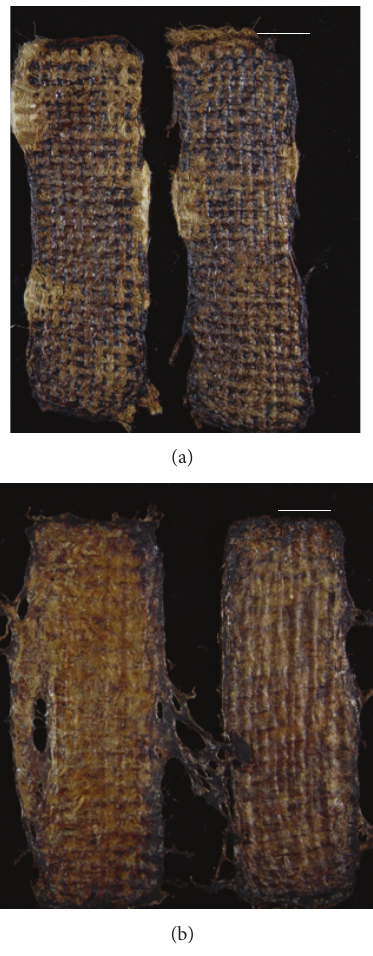
Figure 3: Examples of LCs employing the burlap bag weave fabricated using different preparation procedures. (a) LC obtained from the DAM. (b) LC obtained from MPM. Bar equals 12 mm.